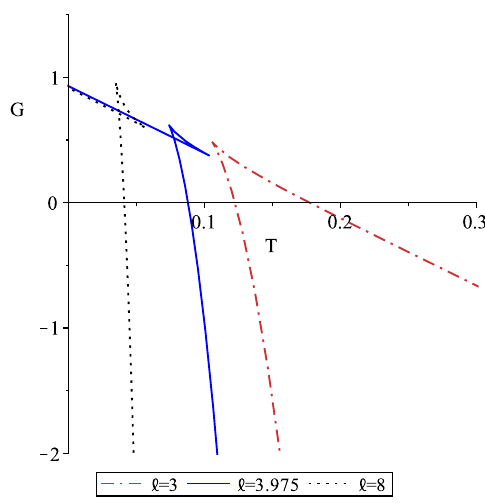
Figure 8 . Breaking Swallowtail. Here we set n = 1 . 3 and Q e = − Q m = 1 . 1 . The larger two values of ‘ correspond to P < P t , and exhibit the familiar swallowtail behaviour. However for P > P t ( ‘ = 3 ) the swallowtail is replaced by a cusp. No second order critical behaviour is observed. This behaviour can occur in case Ia.